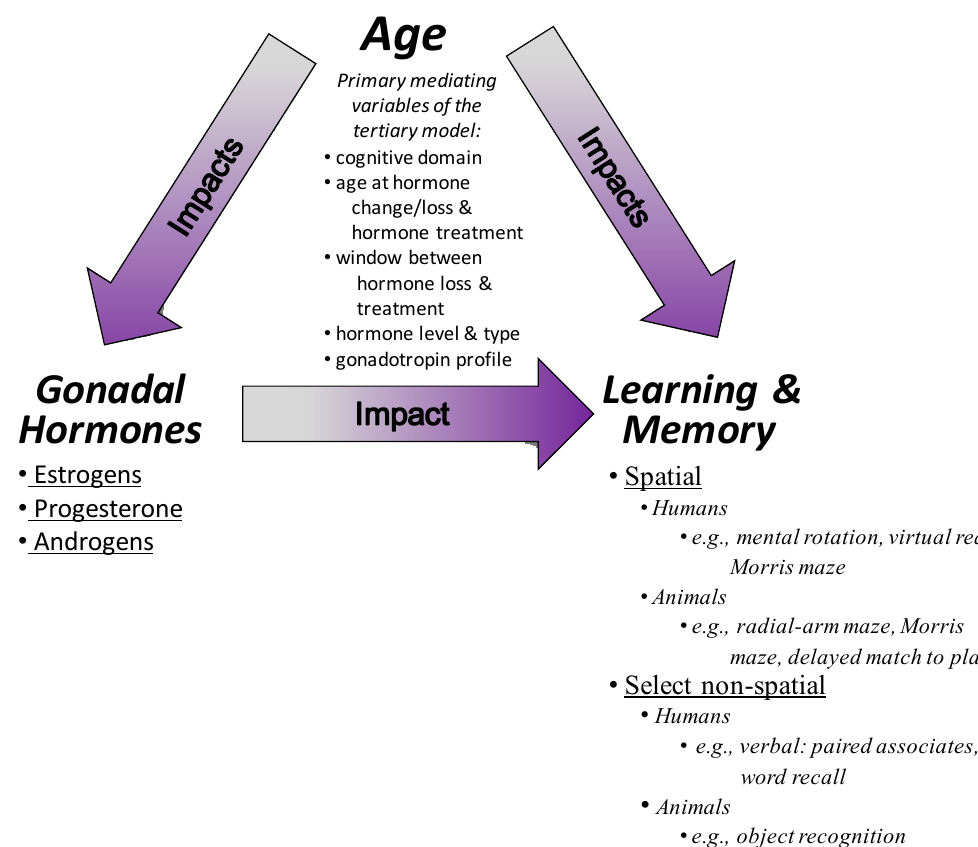
Figure 1. Tertiary model representing interactions between gonadal hormones, memory and